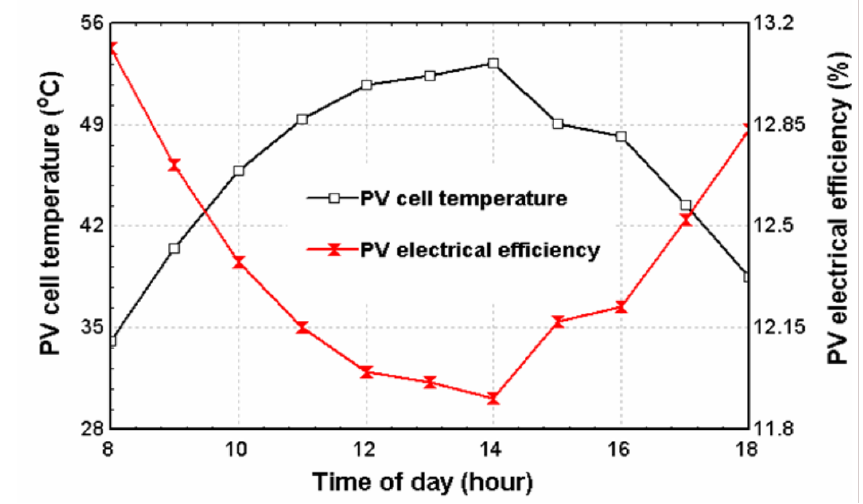
Figure 8. Numerical result of PV